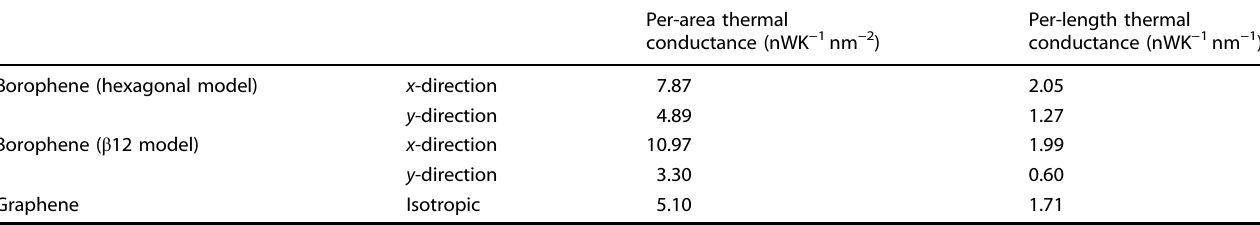
Table 1. A summary of thermal conductance of borophene and graphene at 300 K